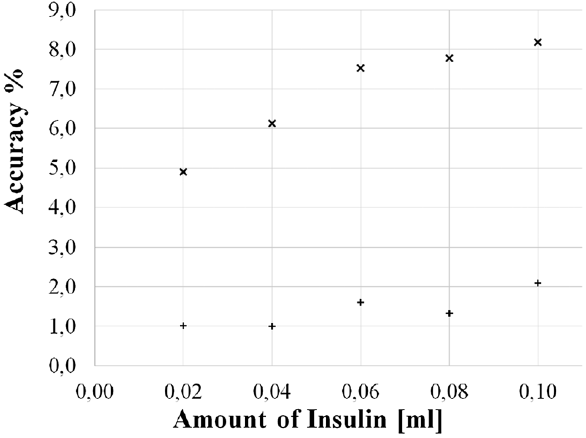
Figure 9. Percentage accuracy of personalized (+) and generic ( × ) model versus amount of drug in ex-vivo experiments.